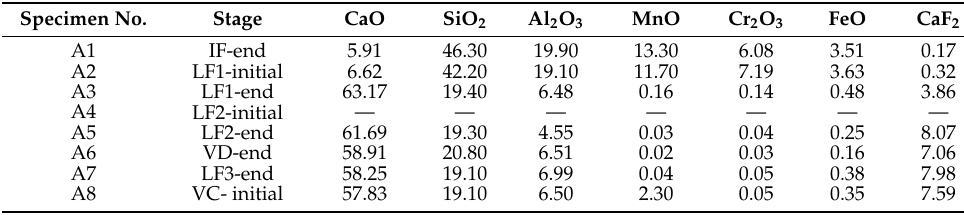
Table 2. Main chemical composition of slag specimens in mass